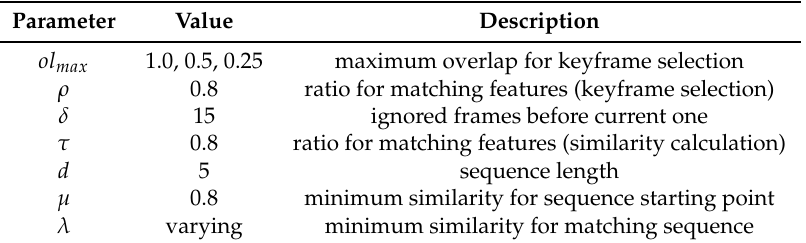
Table 2. Parameter used for the proposed